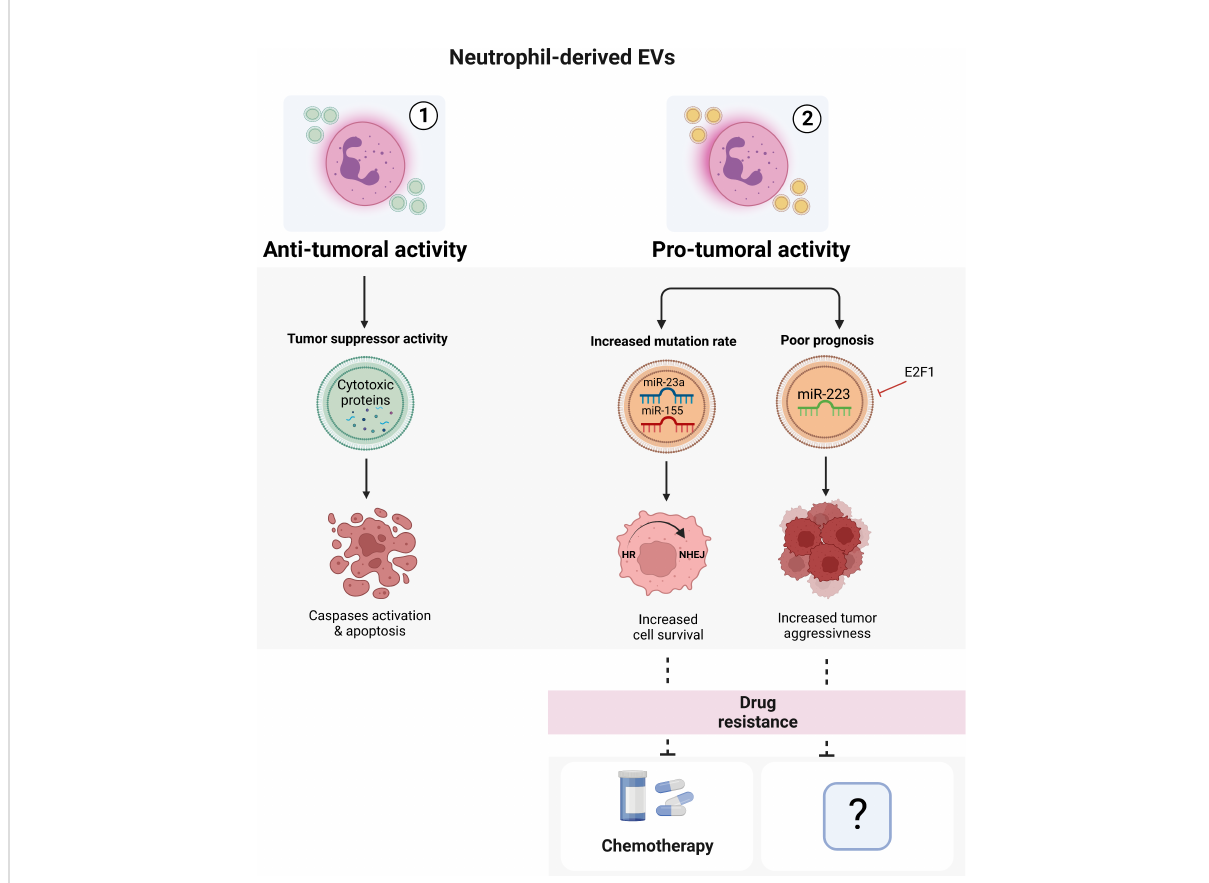
FIGURE 2 Neutrophil-derived EVs. Neutrophil-derived EVs can exert both anti-tumoral (1) or pro-tumoral (2) activities in a context-dependent manner. The EVs isolated from healthy neutrophils can induce apoptosis of cancer cells through the activation of caspases pathway. On the other hand, tumoral neutrophil-derived EVs seem to promote cancer spreading, progression and drug resistance. Image created with